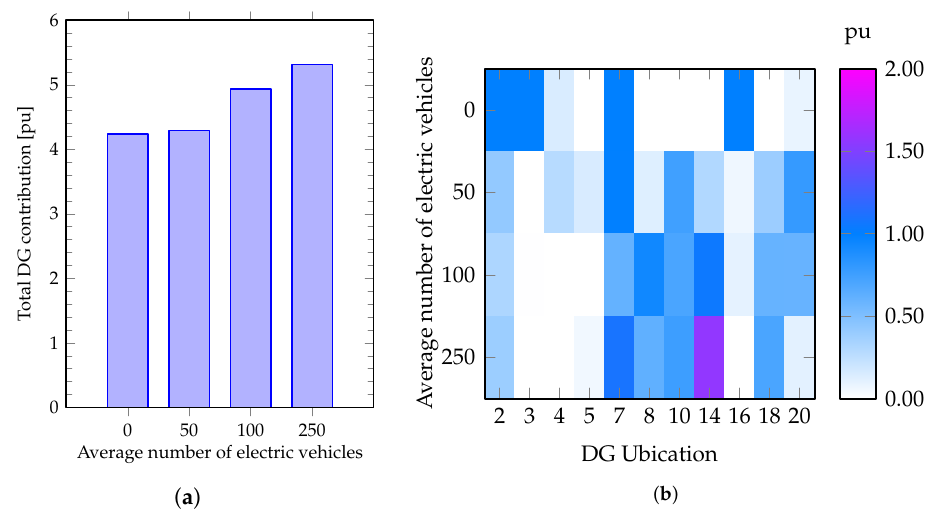
Figure 6. HC evaluation considering different penetration of EVs in the 21-bus DC microgrid. The shades range from white to magenta, with white being 0 pu and magenta being 2 pu. ( a ) DG Contrubition; ( b ) Color map of DG contribution.